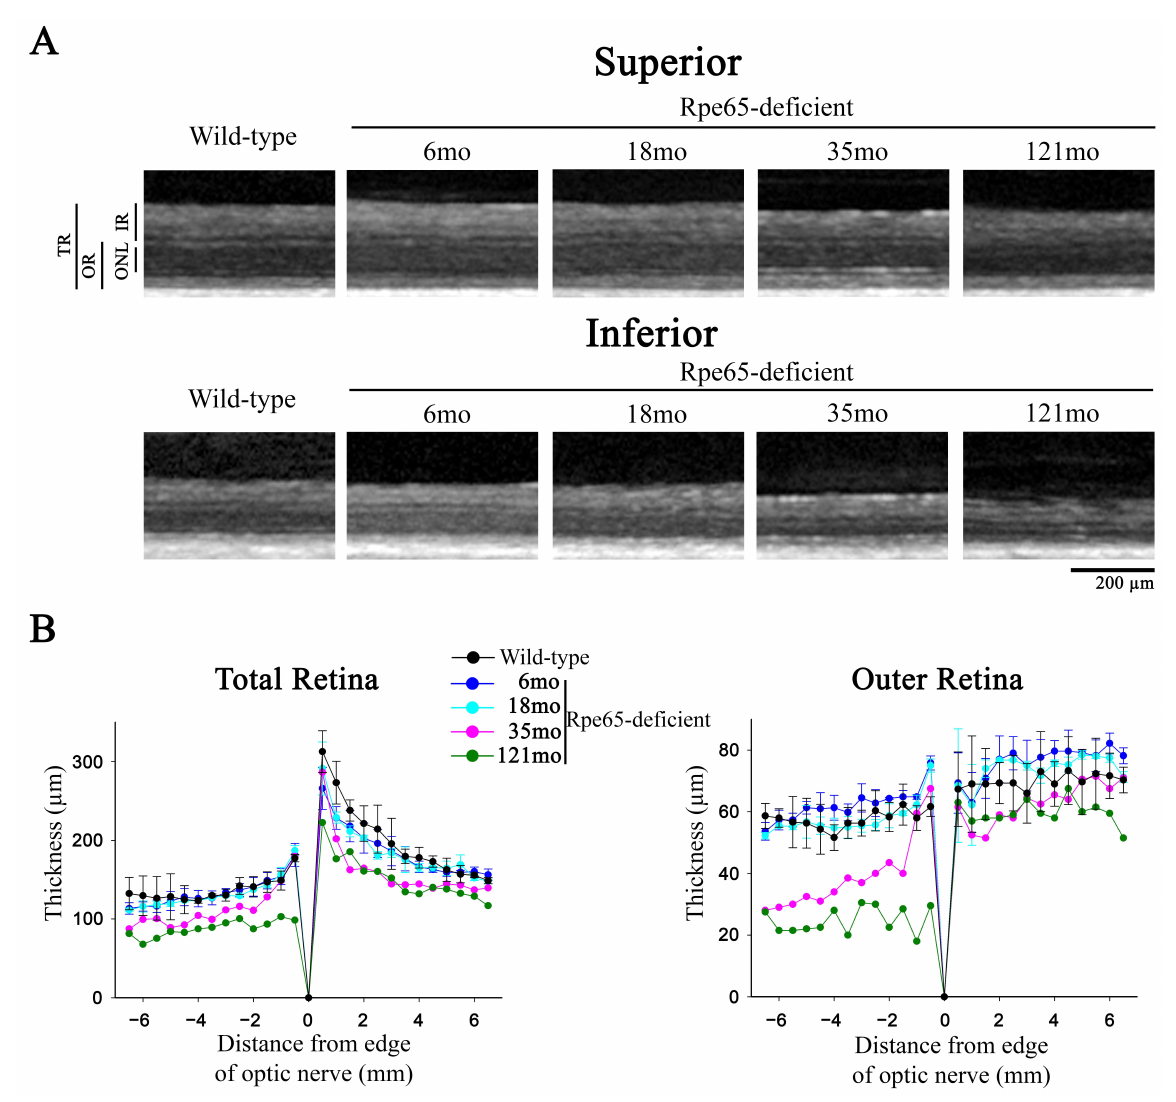
Figure 5. SD-OCT shows that outer retinal thinning with disease progression occurs more rapidly in the inferior retina than the superior retina. ( A ). Representative high-resolution cross-sectional imaging of two retinal regions in wild-type control dog (39-month-old) and 6-, 18-, 35- and 121-month-old Rpe65-deficient dogs at 4 mm superior to the optic nerve head and 4 mm inferior to the optic nerve head. Note the progressive decline in total retinal thickness with age. The thinning is predominantly due to decreases in the outer retinal layers and progresses more rapidly in the inferior retinal region. The difference between the thickness of the outer retinal layers between the inferior and superior retina is pronounced in the 35-month and 121-month-old animals. ( B ). Spidergrams of the total retinal thickness (measured from internal to external limiting membranes) and outer retinal thickness (encompassing ONL to OPL) in a vertical plane through the optic nerve head shown for and 6-, 18-, 35- and 121-month-old Rpe65-deficient dogs (see Table 1) and wild-type control dogs ( n = 3, mean age 35 months). The total retinal thickness is lower in the inferior retina in all dogs. There is a progressive thinning of the outer retina with age, which is most pronounced in the inferior retina. Key: TR, total retina; OR, outer retina; IR, inner retina; ONL, outer nuclear layer; OPL, outer plexiform